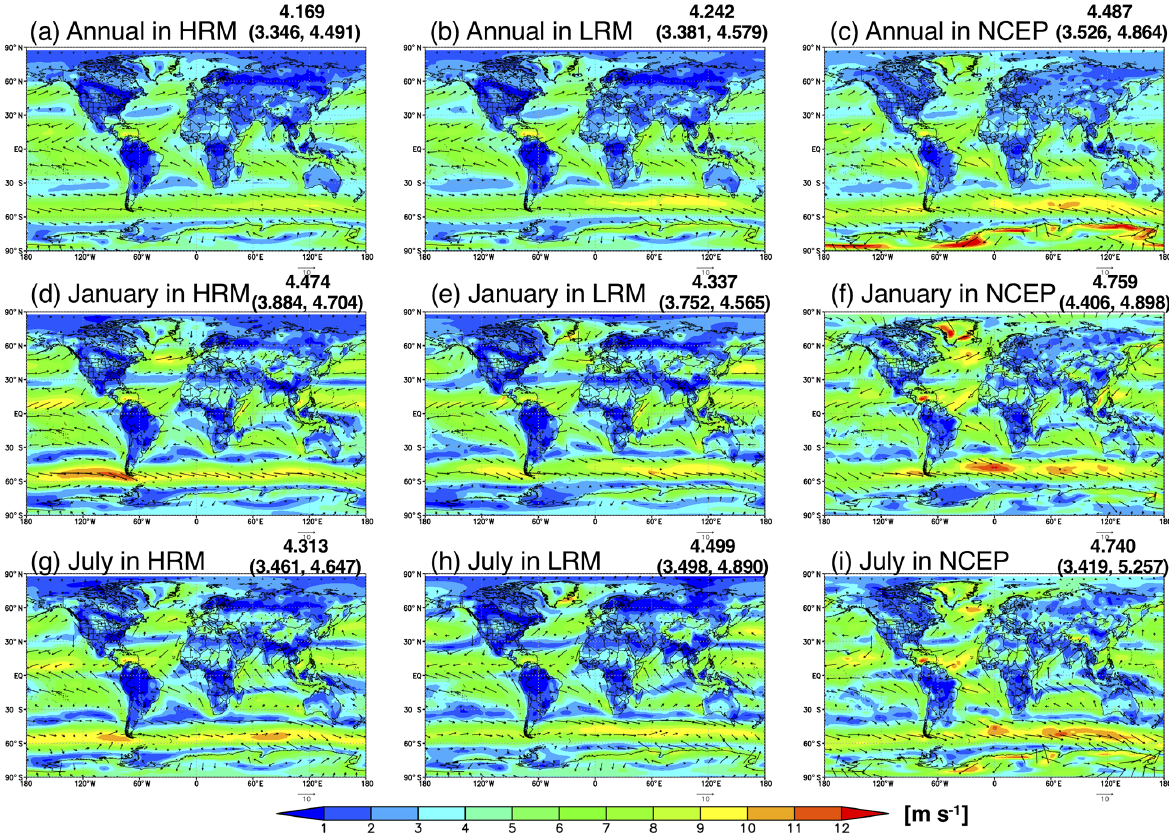
Figure 2. Global distributions of the annual, January and July averages of the wind speed at a height of 10m simulated by the HRM and LRM and reanalyzed by the NCEP. The colors and arrows represent the wind speed and wind direction, respectively. The model results in both the HRM and the LRM are horizontally interpolated onto the NCEP grids (2 . 5 ◦ × 2 . 5 ◦ ). The numbers shown in the upper-right corner in each panel represent the global averages (90 ◦ S–90 ◦ N); those in brackets represent the global land and ocean averages. All units are in ms − 1